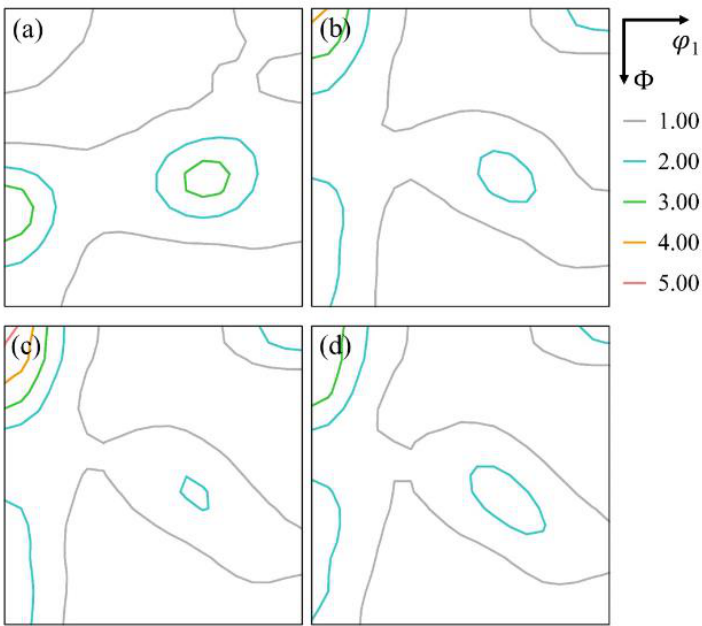
Figure 9. The 45° ODF diagrams of the forged tube with a reduction of 42.7%: ( a ) r = 11.0 mm; ( b ) r = 8.3 mm; ( c ) r = 5.6 mm; ( d ) r = 2.9 mm.